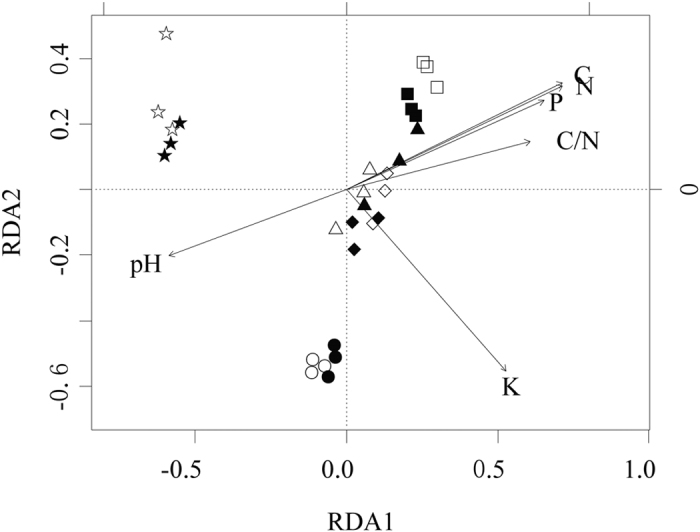
Redundancy analysis (RDA) of sampling sites and soil factors based on bacterial OTUs.The land-use types and their icons are as follows: black locust plantation (⦁ and ⚬), oriental arborvitae forest (◆ and ♢), oak forest (◼ and ◻), shrub land (▴ and ▵), and bare land (★ and ☆), in summer and winter respectively. The figure is generated by using the R v.3.1.3 project (R Development Core Team. 2015).